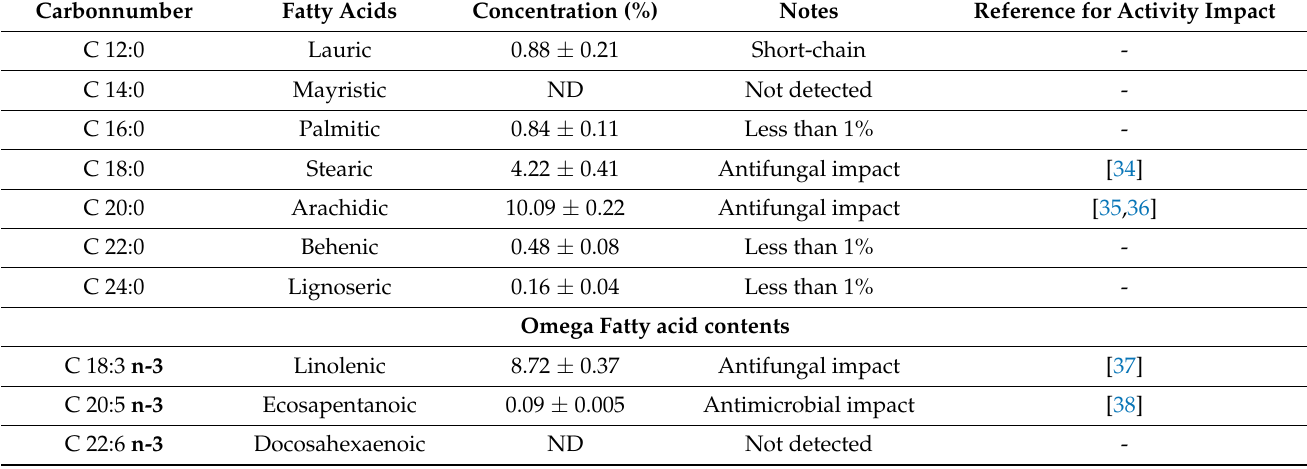
Table 3. Fatty acid composition of the oil extracted from mandarin